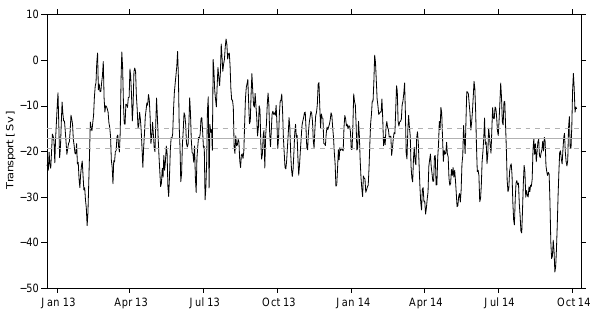
Figure 10. Time series of absolute transport integrated between sites A and B, and between 800 and 4800dbar (or the bottom), dur- ing the period when all instruments were in place. Also shown is the time-mean value (gray solid line) and lines corresponding to the time mean plus or minus 2 standard errors of the mean (gray dashed), i.e., the 95% confidence limit for the mean value. Standard errors were determined following commonly used methods (e.g., Dewar and Bane,